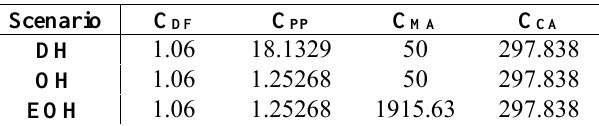
Table 1.The values of four adjustment parameters of flight profile of the missile.